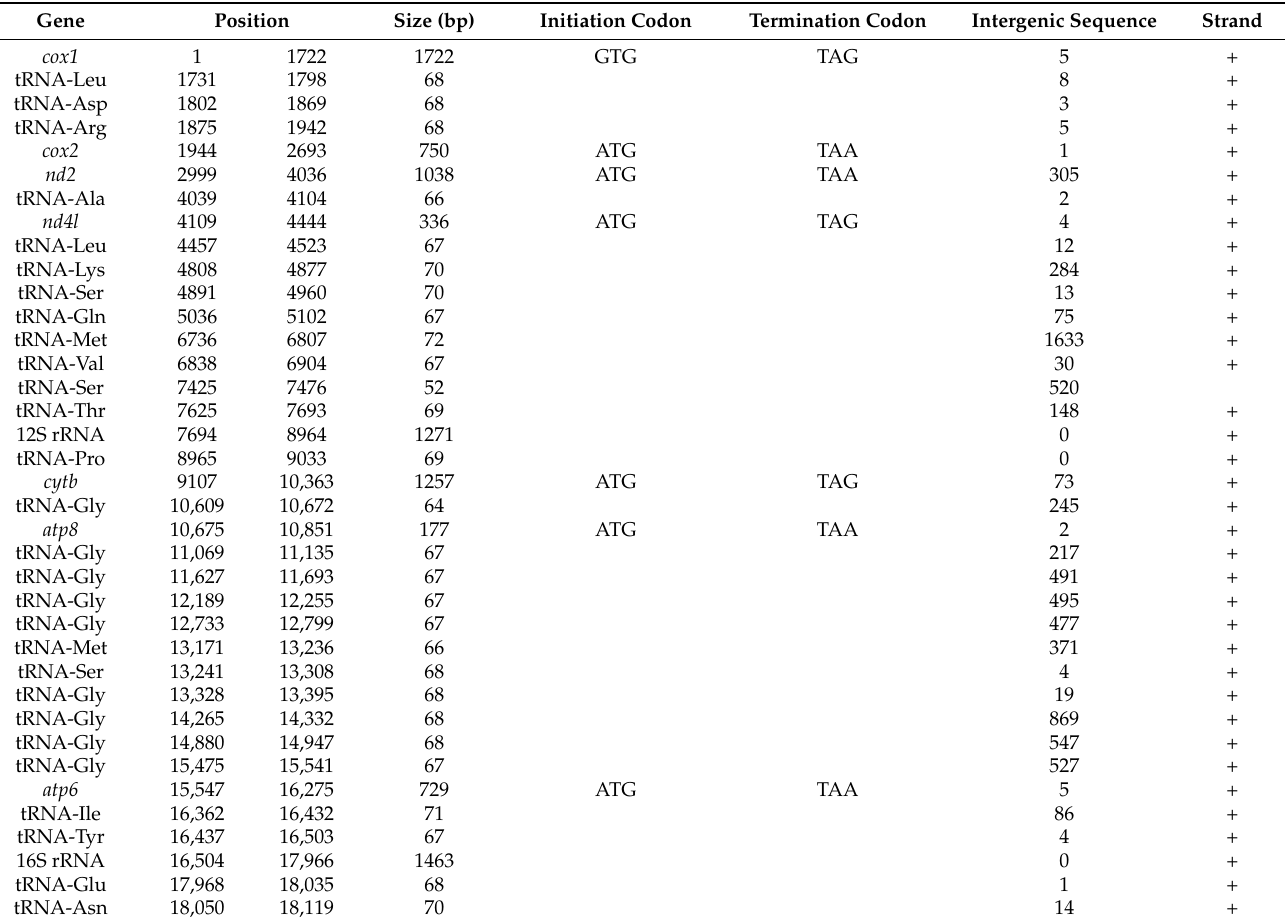
Table 1. Structure and orientations of Lingula anatina complete mitochondrial genome genes collected from Buan, Ko- rea